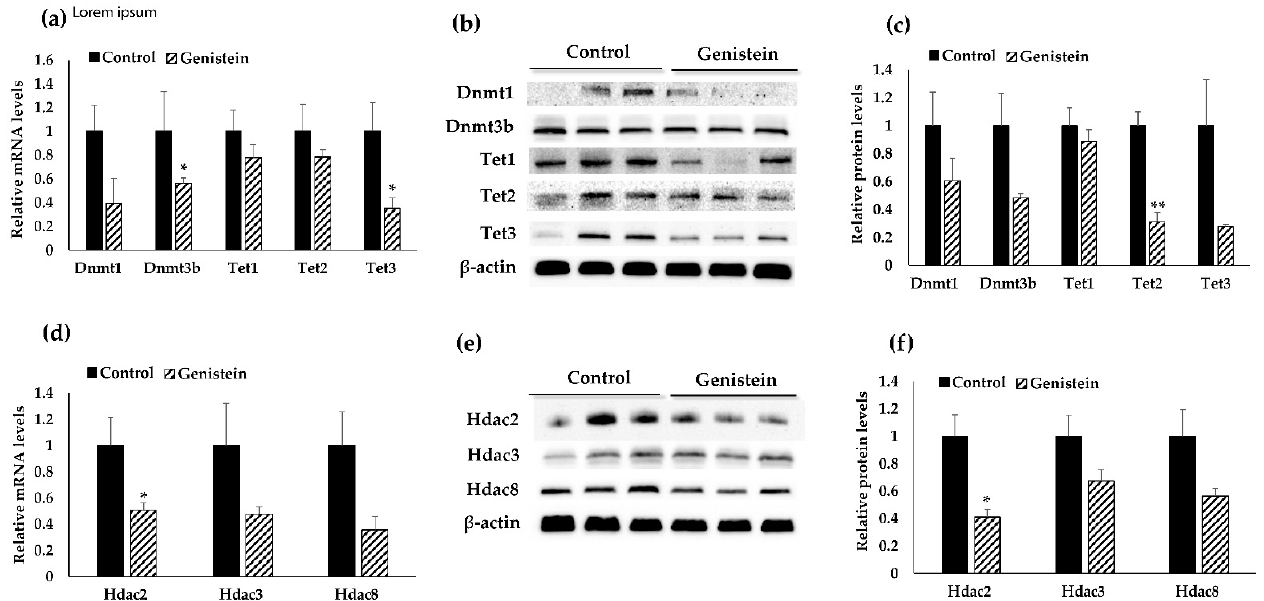
Figure 5. Assessment of transcriptional and protein levels of key epigenetic-related genes. ( a , d ) Dnmt1, Dnmt3b, Tet1, Tet2, Tet3, Hdac2, Hdac3 and Hdac8 gene transcriptional levels by real-time RT-PCR in TNBC PDX tumors in control and GE treatment groups, ( b , e ) Protein levels of these key epigenetic-related genes by Western blot, ( c , f ) Histograms showed quantification of protein levels. Gapdh or β -Actin was used as internal control. Data shown are representative of three independent experiments ( n = 3/patient/group). Columns, mean; Bars, SD; * p < 0.05, ** p < 0.01, significantly different from control group.